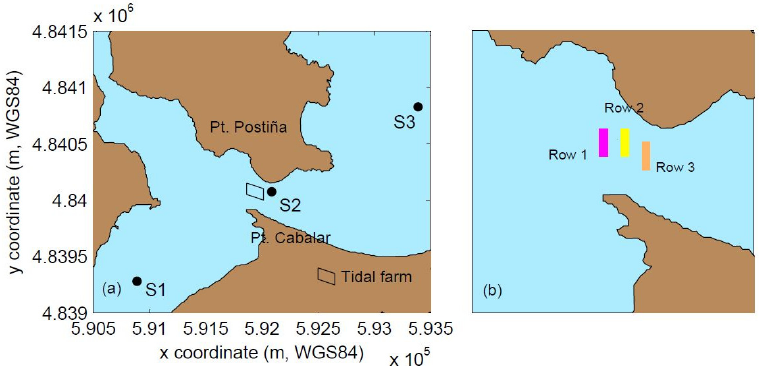
Figure 3. Location of the considered tidal stream plant, indicating the locations (S1, S2, and S3) for velocity and salinity profiles ( a ). Layout in plan view of the plants ( b ).